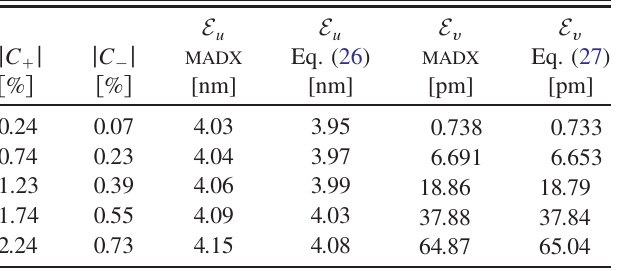
TABLE III. Comparison between the eigenemittance E TABLE IV. Comparison between the eigenemittance E u;v computed by MADX and via Eqs. (26) and (27) for the ESRF computed by MADX and via Eqs. (26) and (27) for a lattice ’ J ¼ 1 and J ’ 2 ). Coupling is storage ring lattice ( J with strong quadrupolar fields in the main bending magnets x y z ’ 0 : 3 , J ¼ 1 , and J ’ 2 : 7 ). Coupling is introduced by ( J introduced by 32 skew quadrupoles and is quantified in the x y z 40 skew quadrupoles and is quantified in the abscissas by abscissas by the resonance stop bands j C þ j and j C (cid:1) j of Ref. [21].